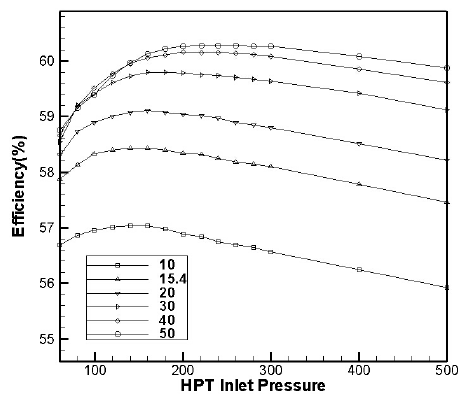
Figure 9. Effects of HPT inlet pressure on efficiency under different intermediate pressure turbine (IPT) inlet